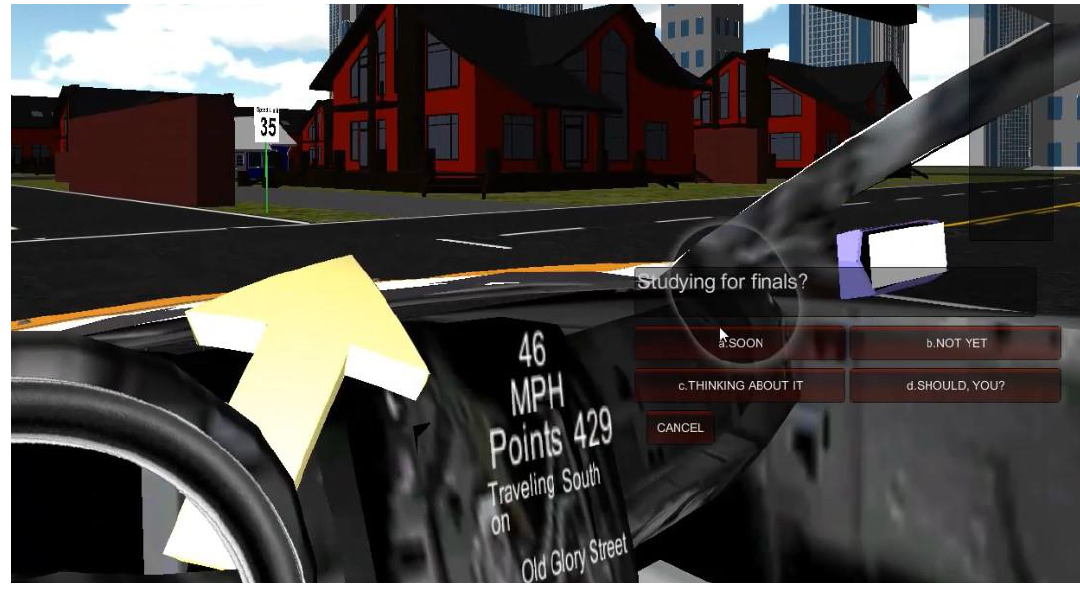
Figure 2. Text messaging system.